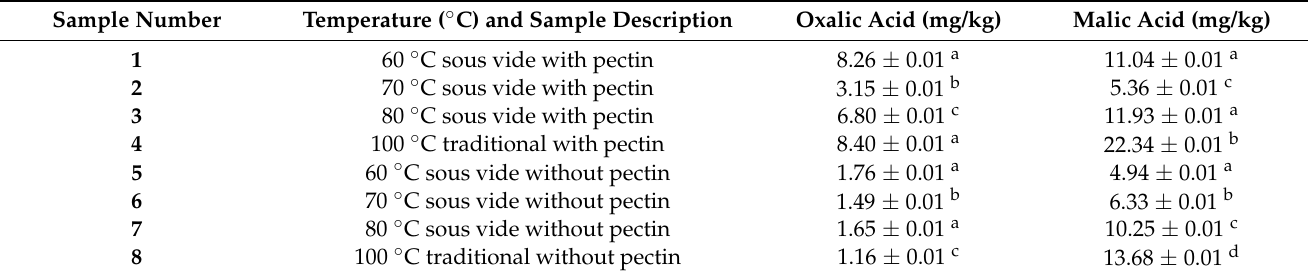
Table 4. Influence of cooking on the total oxalic acid and malic acid content in medlar jam prepared by the sous vide method and the classic cooking